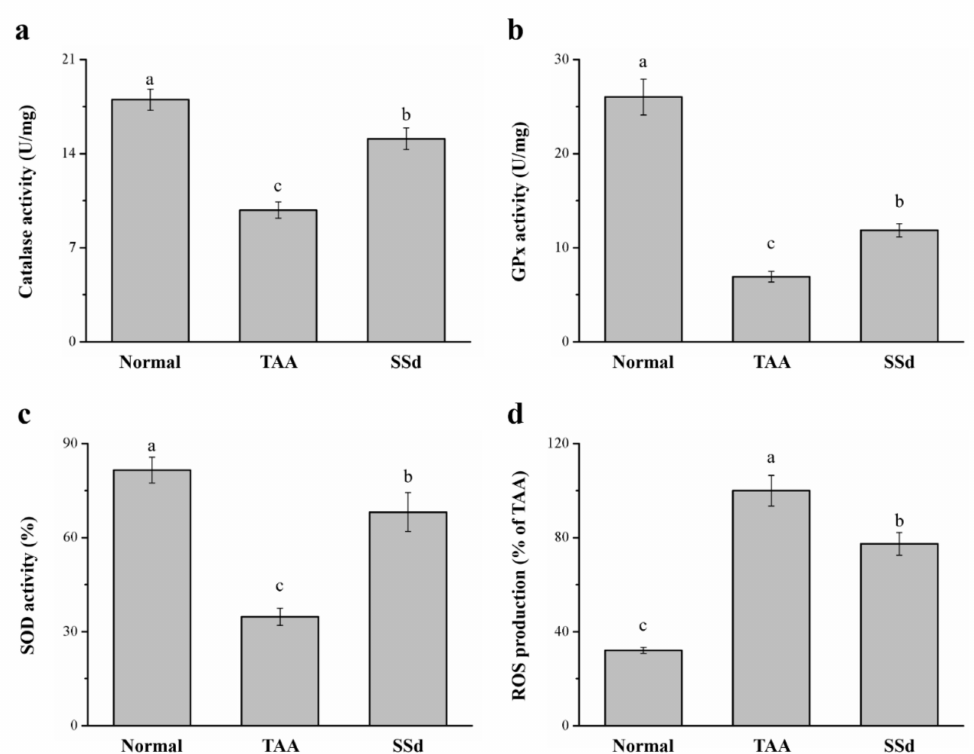
Figure 6. Changes in hepatic ( a ) CAT, ( b ) GPx, and ( c ) SOD activity and ( d ) ROS levels in the control, TAA, and SSd groups over 8 weeks. All data are reported as means ± SD (n = 8). a–c Data with different letters above the columns were significantly different on one-way ANOVA, and Duncan’s test at p < 0.05 was used to compare the means of the three groups. GPx, glutathione peroxidase; CAT, catalase; SOD, superoxide dismutase; ROS, reactive oxygen